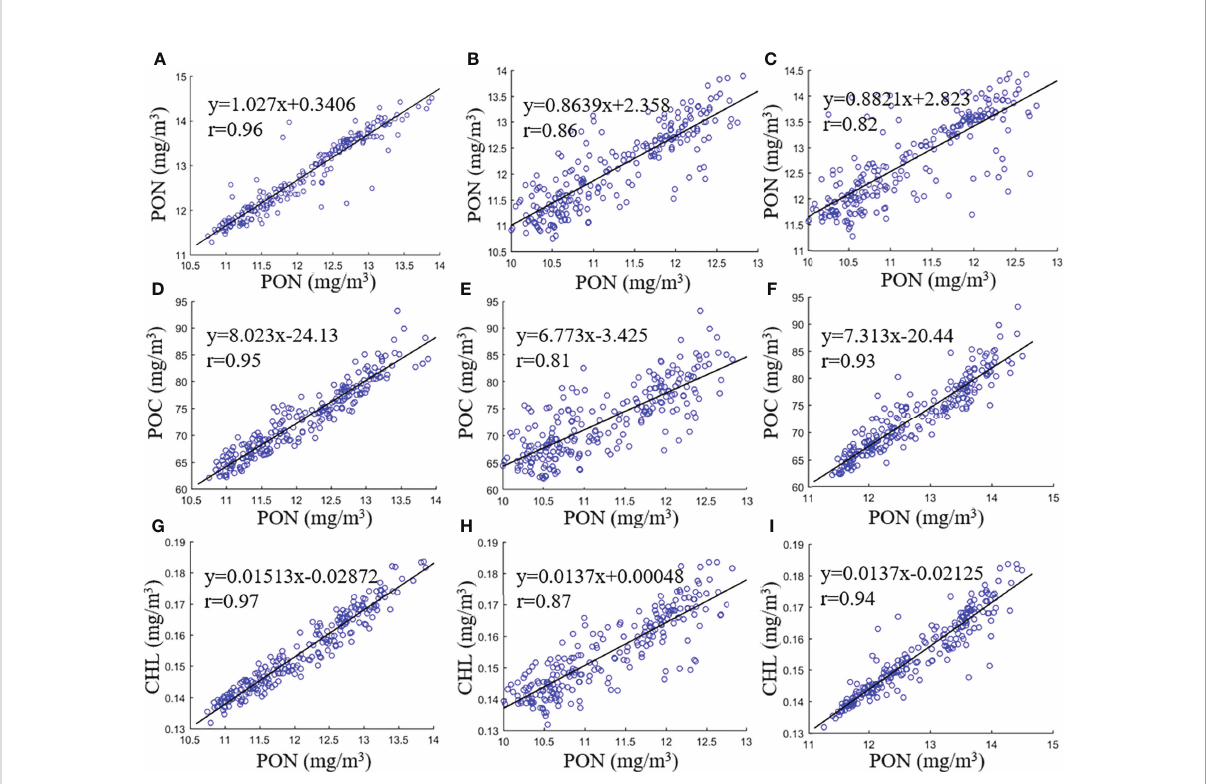
FIGURE 11 Scatterplots of global monthly mean PON concentrations with the CHL- vs. a (488)-based models (A) , a (488)- vs. NDNI-based models (B) , and CHL- vs. NDNI-based models (C) , respectively. Plots (D-F) are the scatterplots of POC vs. PON concentrations derived with the a (488)-, NDNI-, and CHL-based models, respectively, and plots (G-I) are the scatterplots of CHL vs. PON concentrations derived with the a (488)-, NDNI-, and CHL-based models, respectively. The solid black line in each subplot is the linear regression line fi tted with 238 data pairs of global monthly mean